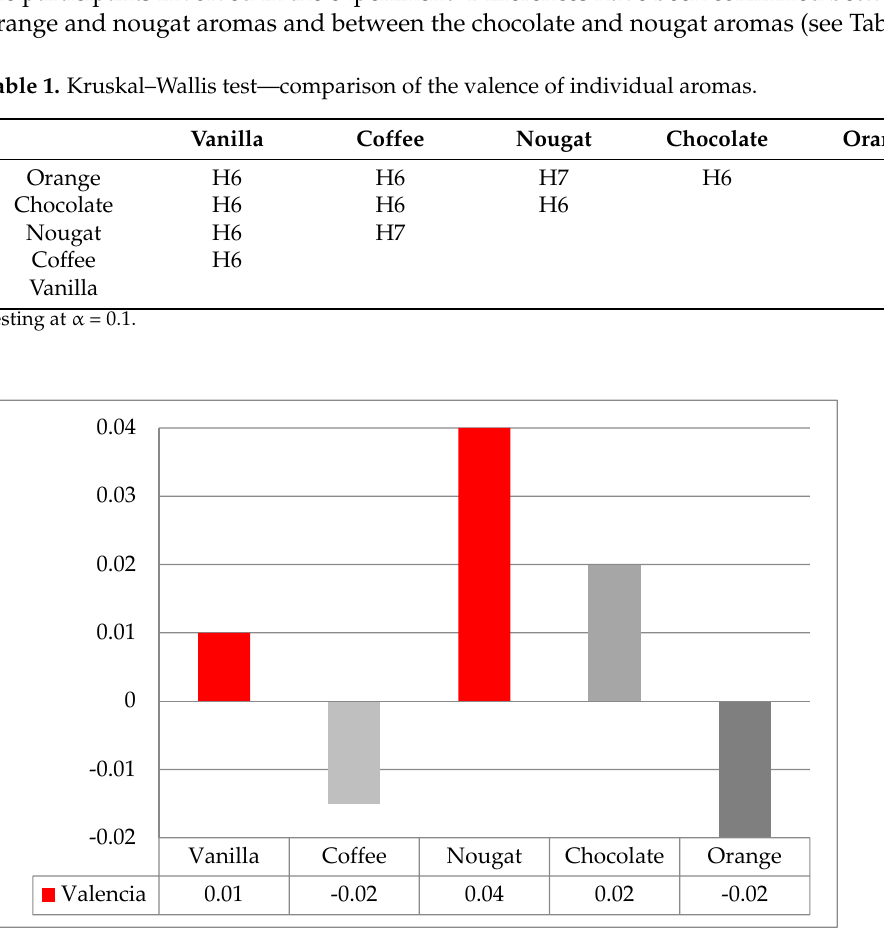
Figure 9. Conscious evaluation of tested aromas under laboratory conditions.